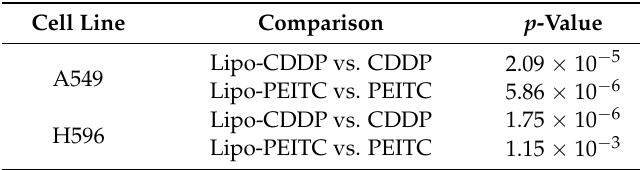
Table 4. Effect of